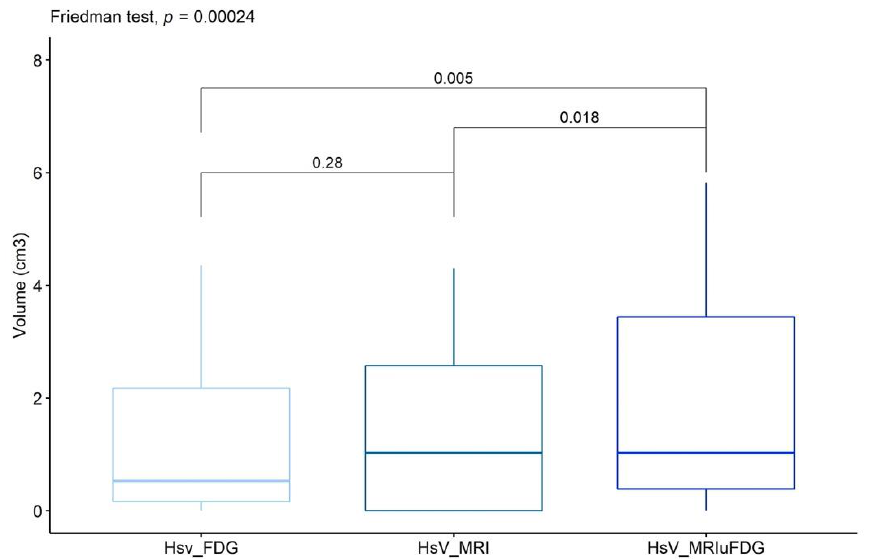
Figure 3. Wilcoxon signed-rank tests between the hypoxic sub volumes HsV_FDG (light blue), HsV_MRI (south sea blue), and HsV_MRIuFDG (dark blue).